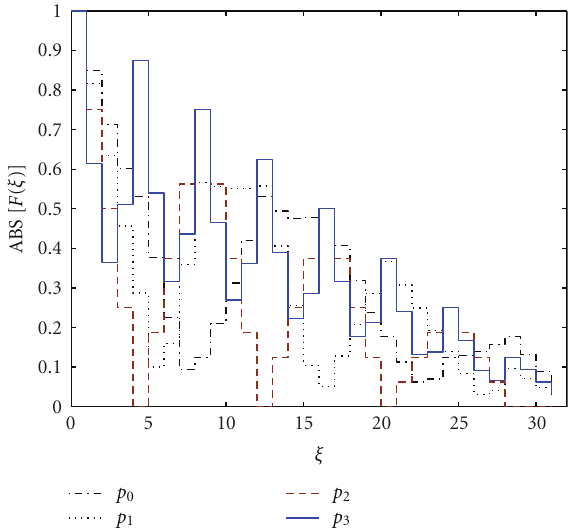
Figure 14: Autocorrelation of the PTS sequences for N = 32, v = 3, P = 4, r = 2, with m -sequence and ECC subblocks, p